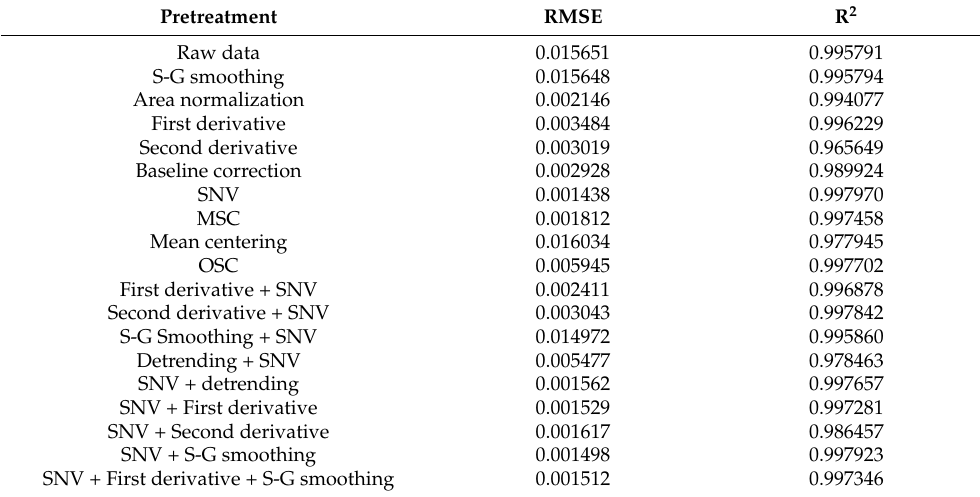
Figure 7. Accuracy of the testing set of Ophiopogon japonicus with SVM for the raw spectra, where blue is the actual value and red is the validation value. Table 2 shows the accuracy values of the training and testing sets after nine spectral pretreatments combined with SVM models. As can be seen from Table 2, after baseline correction, SNV, MSC and mean centralization, the accuracy of the training and testing sets has been significantly increased. After comparison, the accuracy of the training and testing sets could be increased to 99.73% and 98.40%, respectively, demonstrating that the SNV pretreatment method had the best effect. Although the second derivative algorithm can eliminate the interference caused by baseline and background to a certain extent, it also introduces some errors in the analysis process, which may reduce the accuracy of the training and test sets. On the basis of SNV, combined with first derivative, second deriv- ative, S-G smoothing, and detrending, the results show that SNV + S-G smoothing has higher accuracy than other combination methods. However, SNV has the best effect. Ac- cording to the calculation results of SNV, the accuracy, recall rate, and F1 scores of the